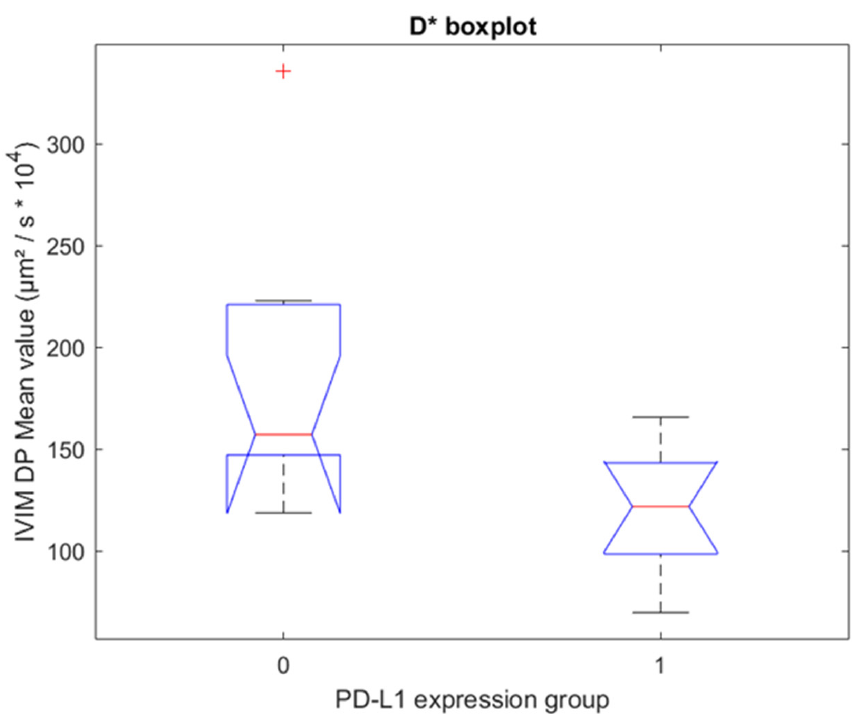
Figure 3. Boxplot for fixed-size ROIs. One boxplot for each group of PD-L1 expression (0 = no expression, 1 = positive expression), with the distribution of the 19 patients’ D* values for algorithm 0. Group 0 and Group 1 have statistically significant different median values ( p = 0.008, Wilcoxon– Mann–Whitney test).